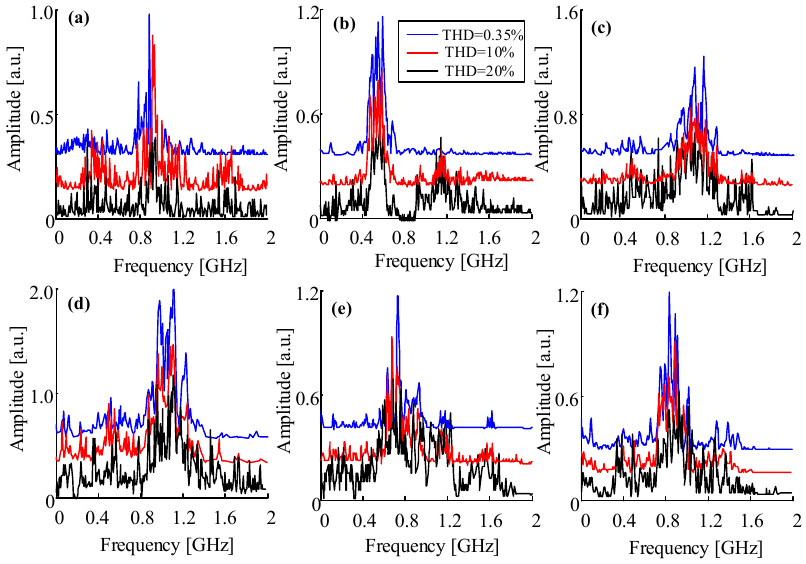
Figure 8. FFT spectra of different PD models, the subfigure ( a – f ) refers to model a to model f. Table 3. Central frequency of different PD defect models (THD = 0.35%).